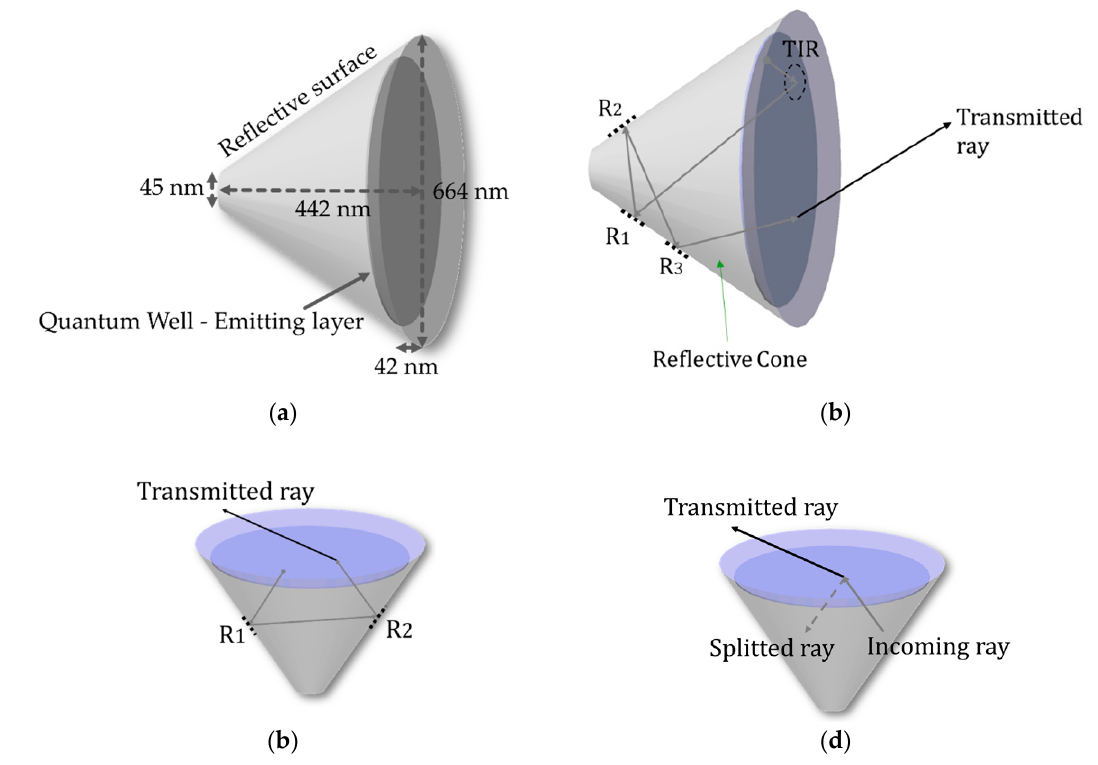
Figure 3. ( a ) LENS pixel Cone LED structure; ( b ) a typical ray path inside a reflective conical LED obtained with LightTools software; ( c ) inwards emission light path; ( d ) outgoing ray split by Fresnel reflection.